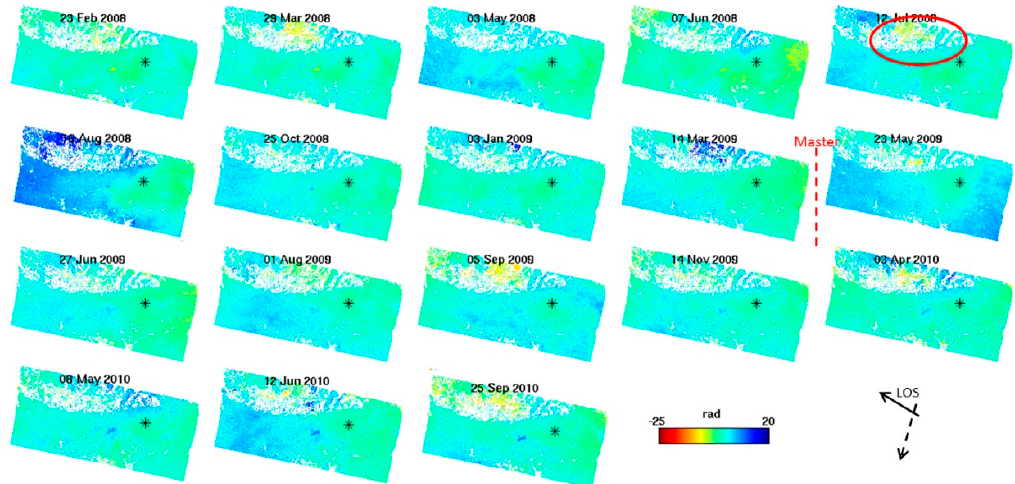
( c ) Unwrapped interferograms corrected for DEM errors and estimated tropospheric phase delays Figure 3. ( a ) Unwrapped time series interferograms corrected for DEM errors, containing tropospheric phase delays and deformation phases; ( b ) Spatial maps of K ’ estimated by our RMW method; ( c ) Final unwrapped differential interferograms corrected for DEM errors and the tropospheric phase delays using our RMW method. The master date is 18 April 2009 and the asterisk represents the center of the reference area with a 300-meter radius. A change of 2 π radians corresponds to a 28 mm displacement in the LOS direction.